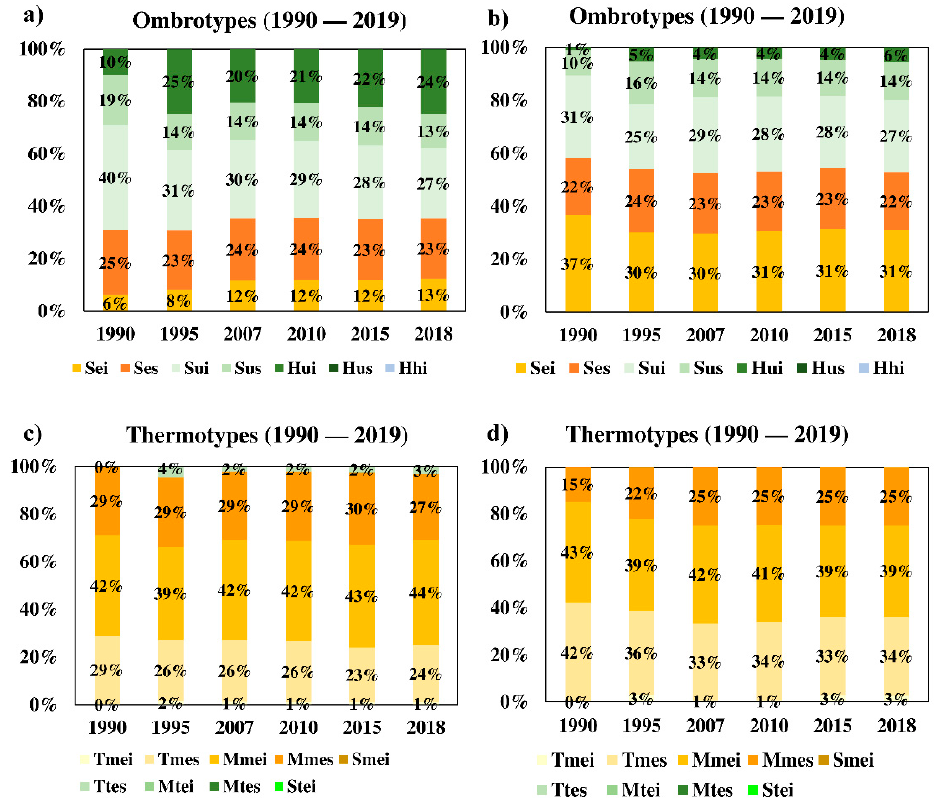
Figure 7. Percentage area regarding each land use and occupation map for vineyards ( a , c ) and olive groves ( b , d ) according to each specific climatic classification: ( a , b ) ombrotype and ( c , d ) thermotype for the recent past period (1990–2019).